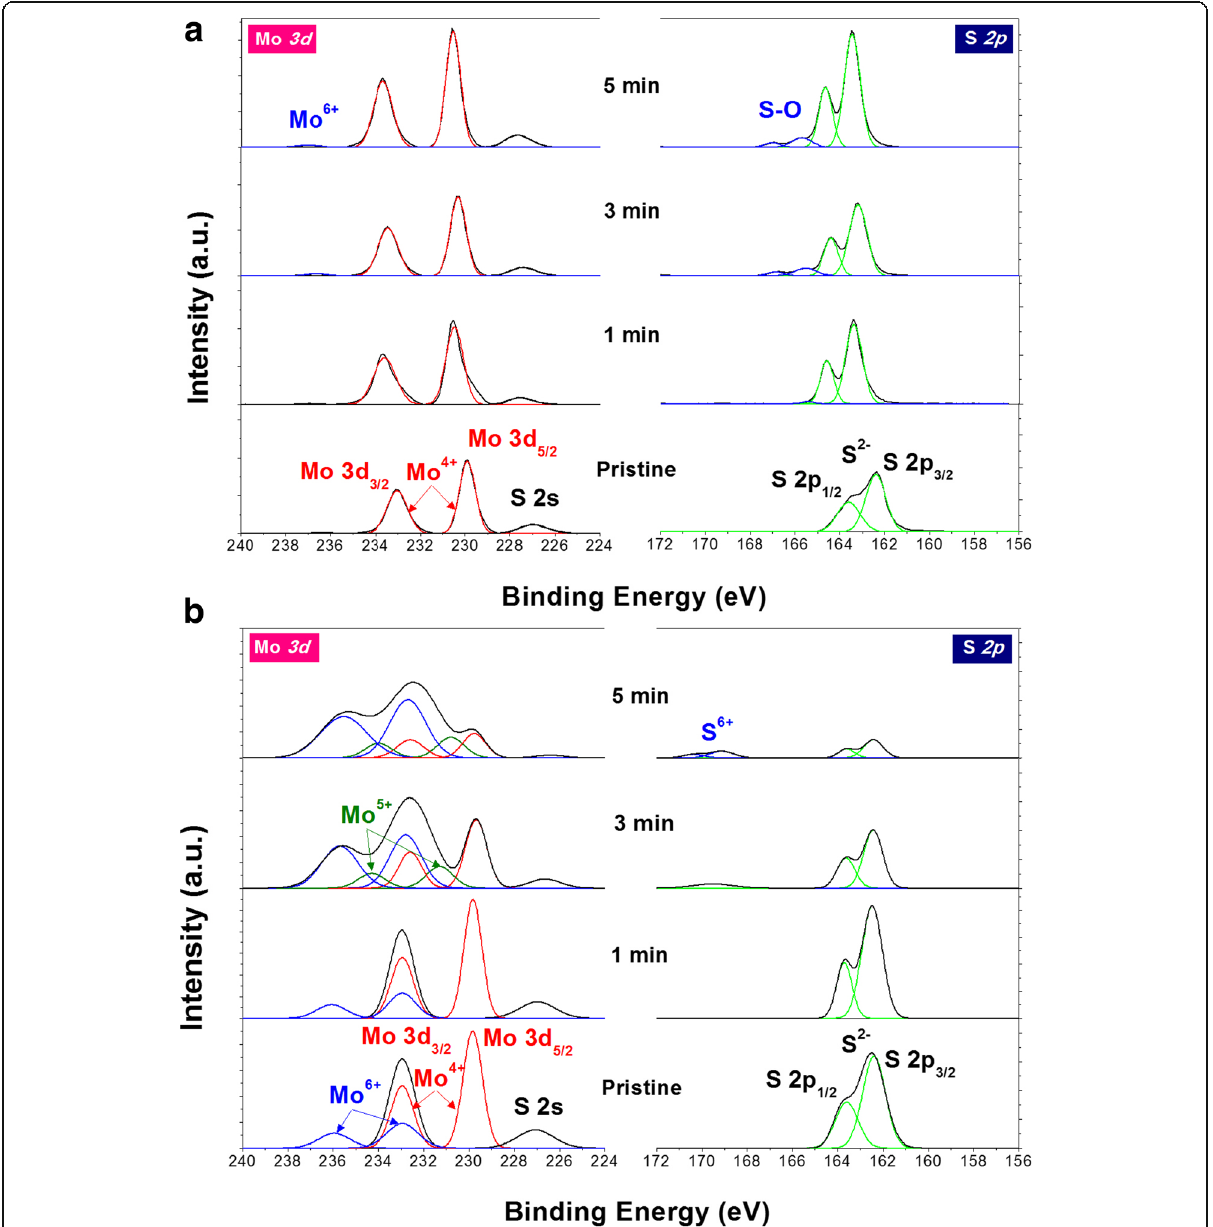
Fig. 5 XPS spectra of MoS 2 a bulk single crystal and b CVD thin films on sapphire substrates after UV-O 3 treatment for 0, 1, 3, and 5